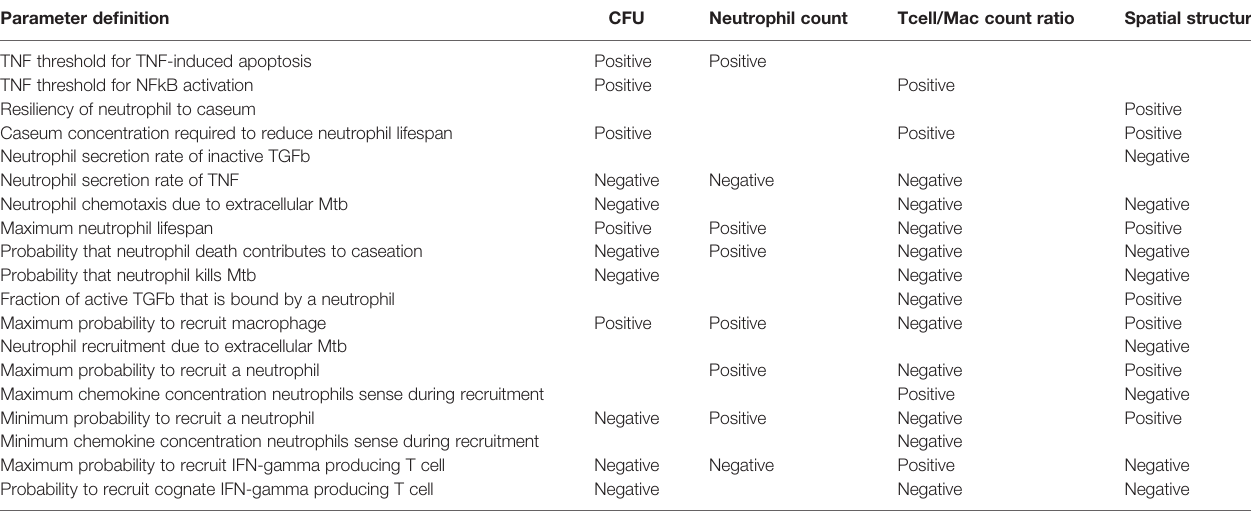
Shown are parameters that are signi fi cant for at least 35 consecutive days during the 200-day span (p < 0.001). If the correlation sign was both positive and negative during the 200 days, then each sign was considered separately for the 35-day requirement. See Methods for a description of the spatial structure